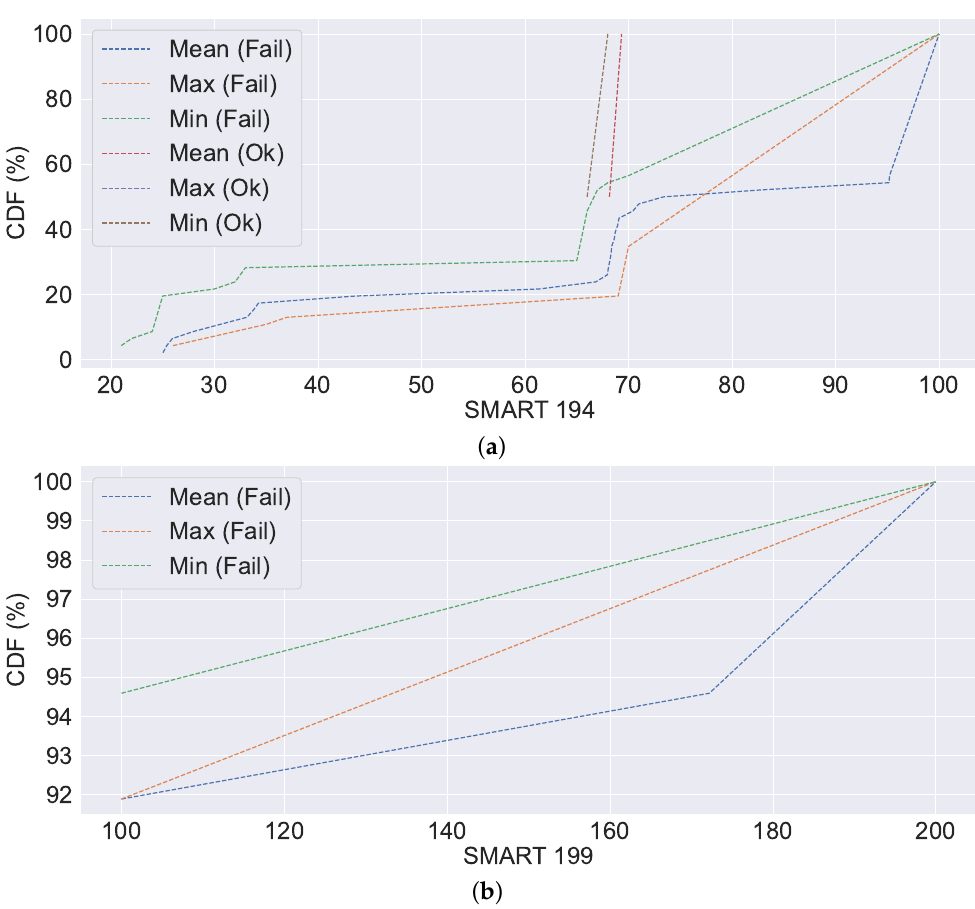
Figure 14. Visualisation of the CDF of network overhead and IO utilisation. ( a ) CDF of network overhead; ( b ) CDF of IO utilisation.